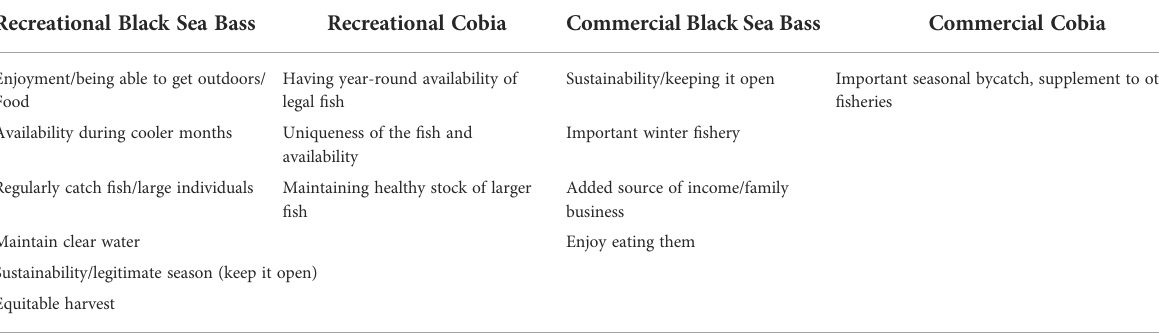
TABLE 2 Responses to interview Question 1 by sector (recreational or commercial) and species (black sea bass or cobia). Recreational Black Sea